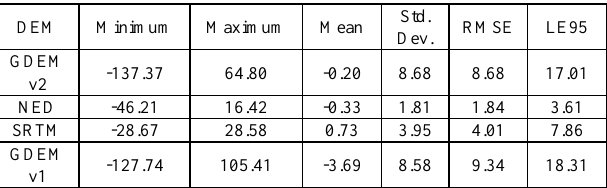
Table 1. Error statistics (meters) from an accuracy assessment vs. NGS GPS benchmarks.